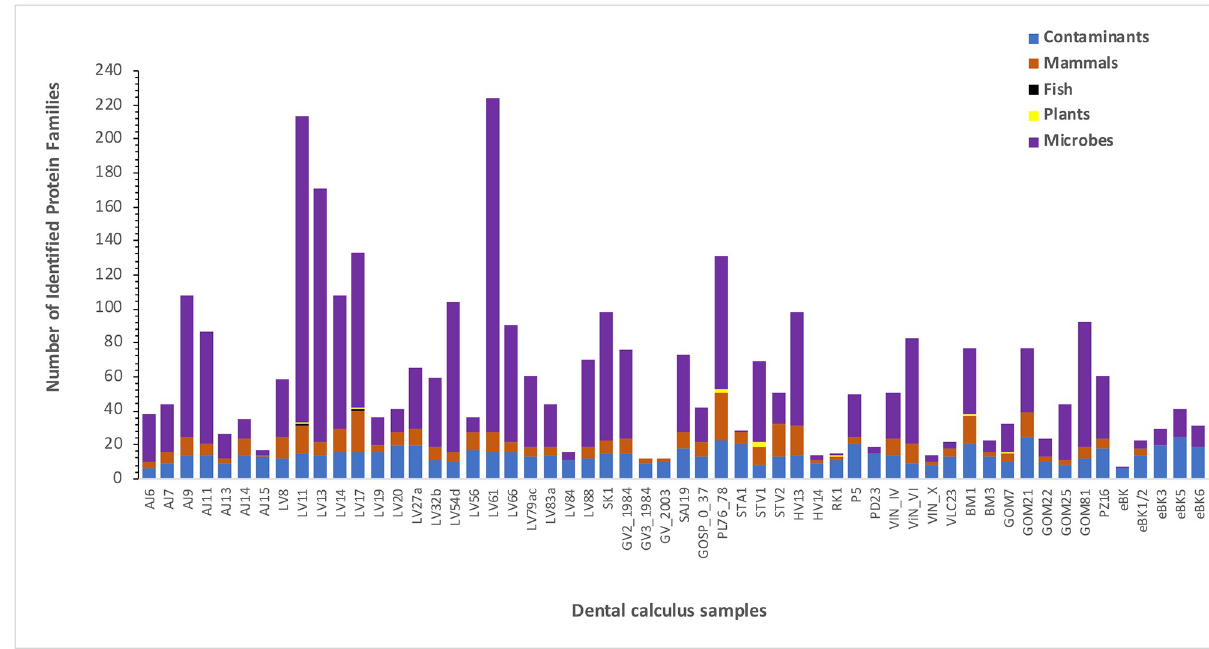
Fig 8. Proportion of contaminant, mammalian, plant, fish, and microbial protein families identified in the dental calculus samples. Many samples are marked by a high proportion of contaminants (predominantly keratins), which could be due to sample handling or general low abundance of endogenous